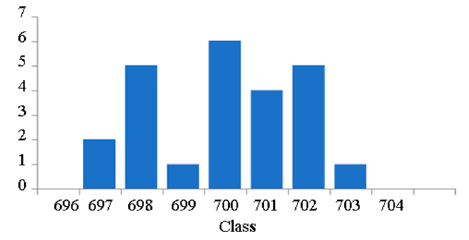
Figure 1. Histogram of the selected sample.